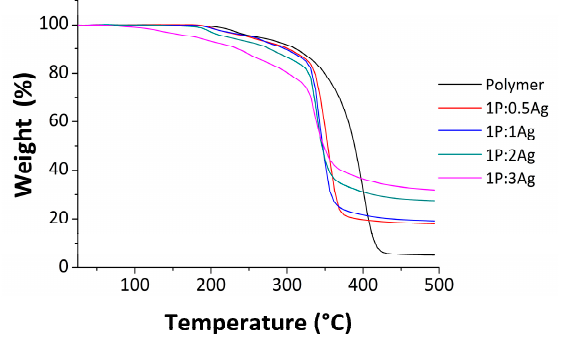
Figure 8. TGA curves of the polymer A and the